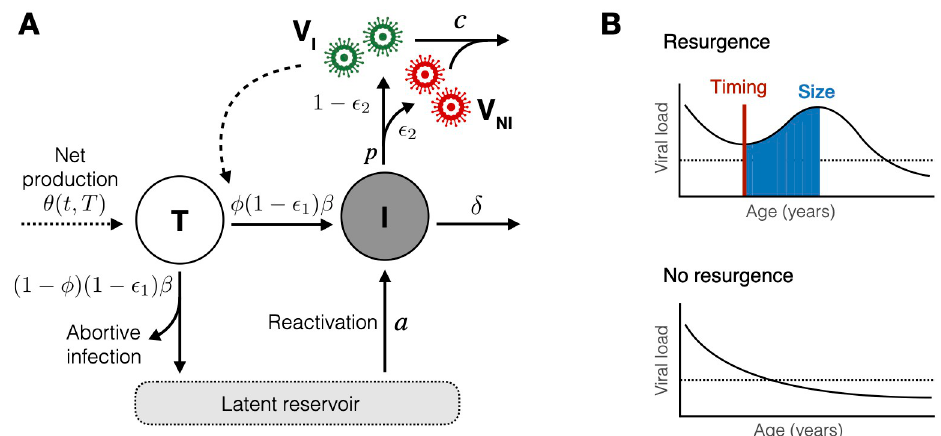
Fig 1. Model framework and analysis schematic. (A) The infection model with rate constants. CD4 target cells (T) are infected by free infectious virus (V I ) and either become productively infected cells (I), die though abortive infection, or become latently infected. Productively infected cells produce both infectious (green) and non-infectious (red) virus, both of which are cleared at rate c , and latently infected cells can become reactivated at a later point to join the productively infected cell population. CD4 target cells also undergo reconstitution and natural decline processes at total net rate θ ( t , T ). Further details are given in the text. (B) Schematic illustrating the definition of viral resurgence (top) compared to no resurgence (bottom). The timing of resurgence is defined as the time at which viral load first starts increasing (vertical red line), and the size of resurgence is the total integrated viral load during the upslope period (blue shaded region). The dashed horizontal line represents the detection threshold of the assay.